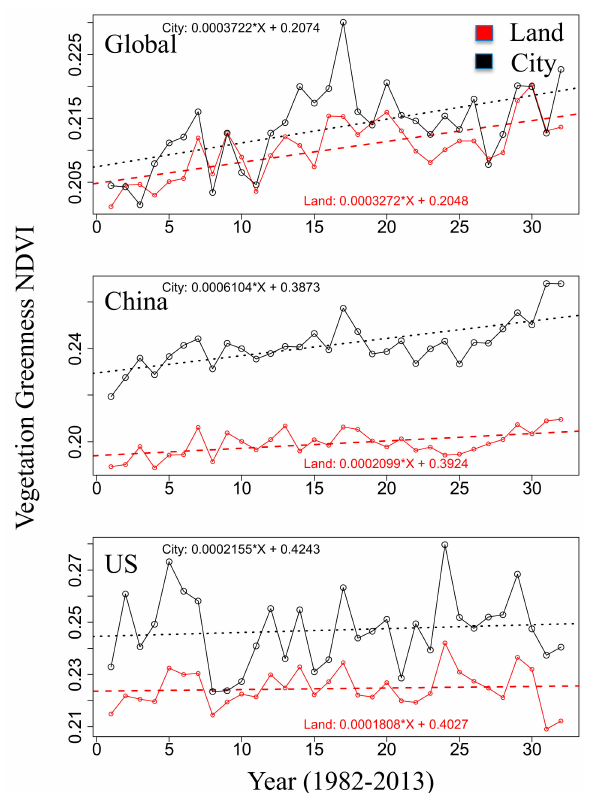
Figure 6. Linear regression statistics of annual averaged vegetation greenness NDVI over land versus within cities for the Globe, China and America: (upper row) global NDVI ranging from 0.1 to 0.3, (middle row) China NDVI from 0.2 to 0.5, and (bottom row) America NDVI from 0.2 to 0.5. Note that the NDVI-intervals selected correspond with the obvious land and city contrast (see arrows in Figure 4). Note that ERA-Interim energy fluxes are provided as half-day integrals ( J m − 2 − 1 m yr ) and converted to water equivalents of 10 3 kg m